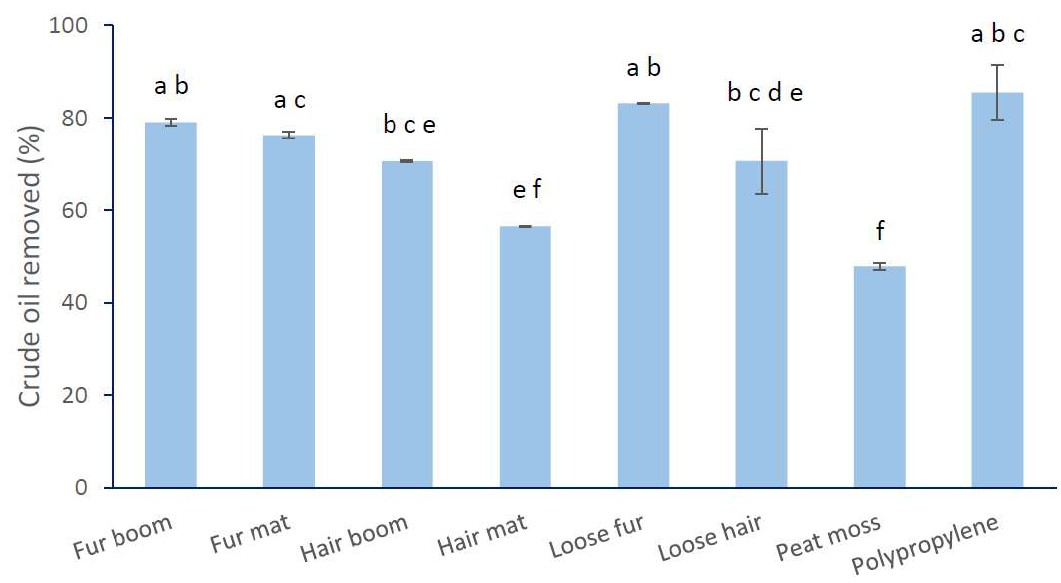
Figure 3. Crude oil adsorbed by different materials on a semi-porous, tile surface.